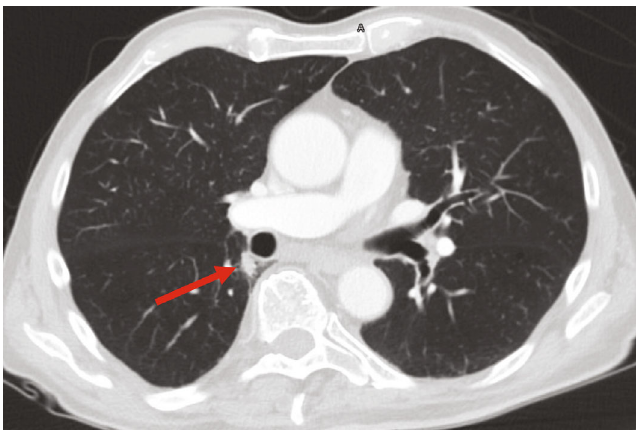
Figure 1: CT of the chest following treatment for peripheral T-cell lymphoma showing a new 1.2 cm nodule in the medial right lower lobe just posterolateral to the distal bronchus intermedius. The nodule appears solid with smooth and spiculated margins and surrounding subtle interstitial thickening. No other obvious abnormalities were noted on CT imaging.